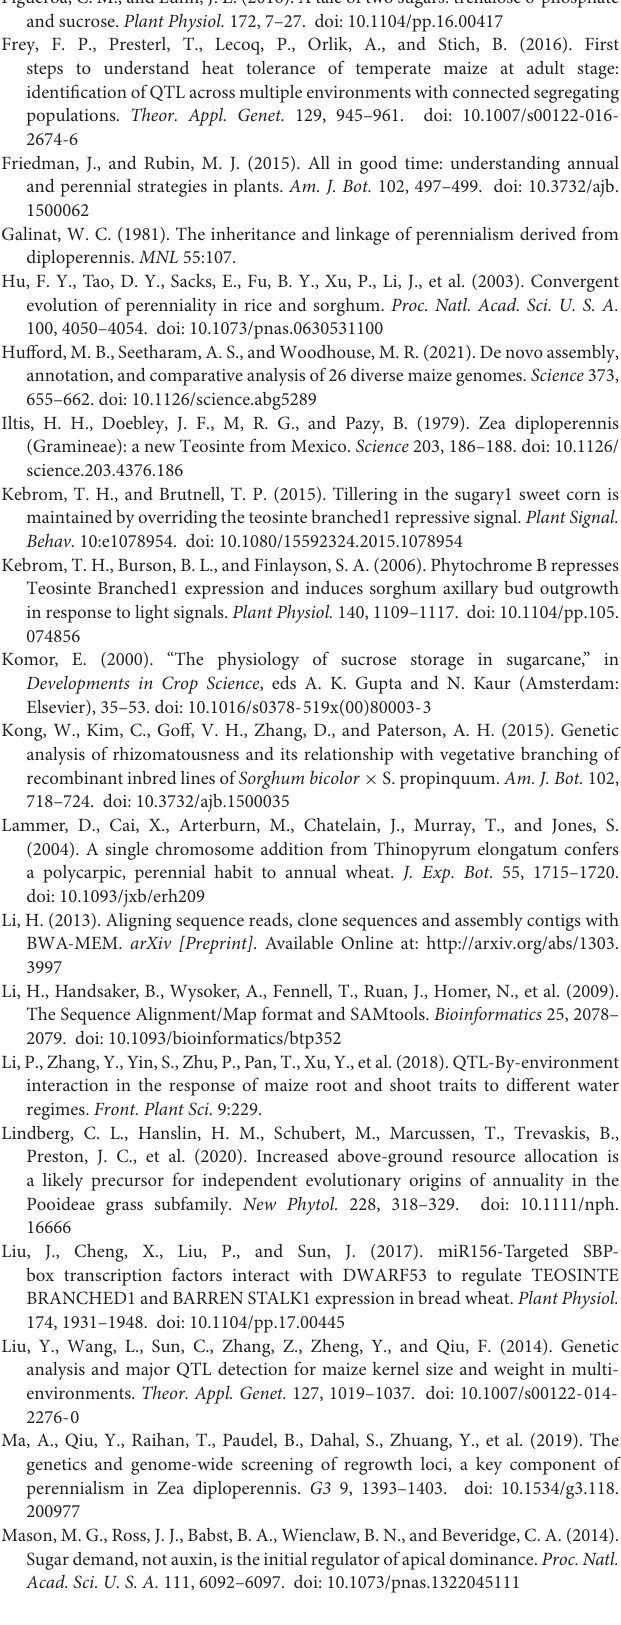
Figueroa, C. M., and Lunn, J. E. (2016). A tale of two sugars: trehalose 6-phosphate and sucrose. Plant Physiol. 172, 7–27. doi: